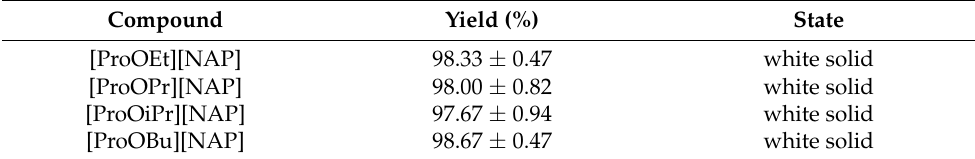
Table 1. Yields of the synthesized L-proline alkyl ester naproxenates